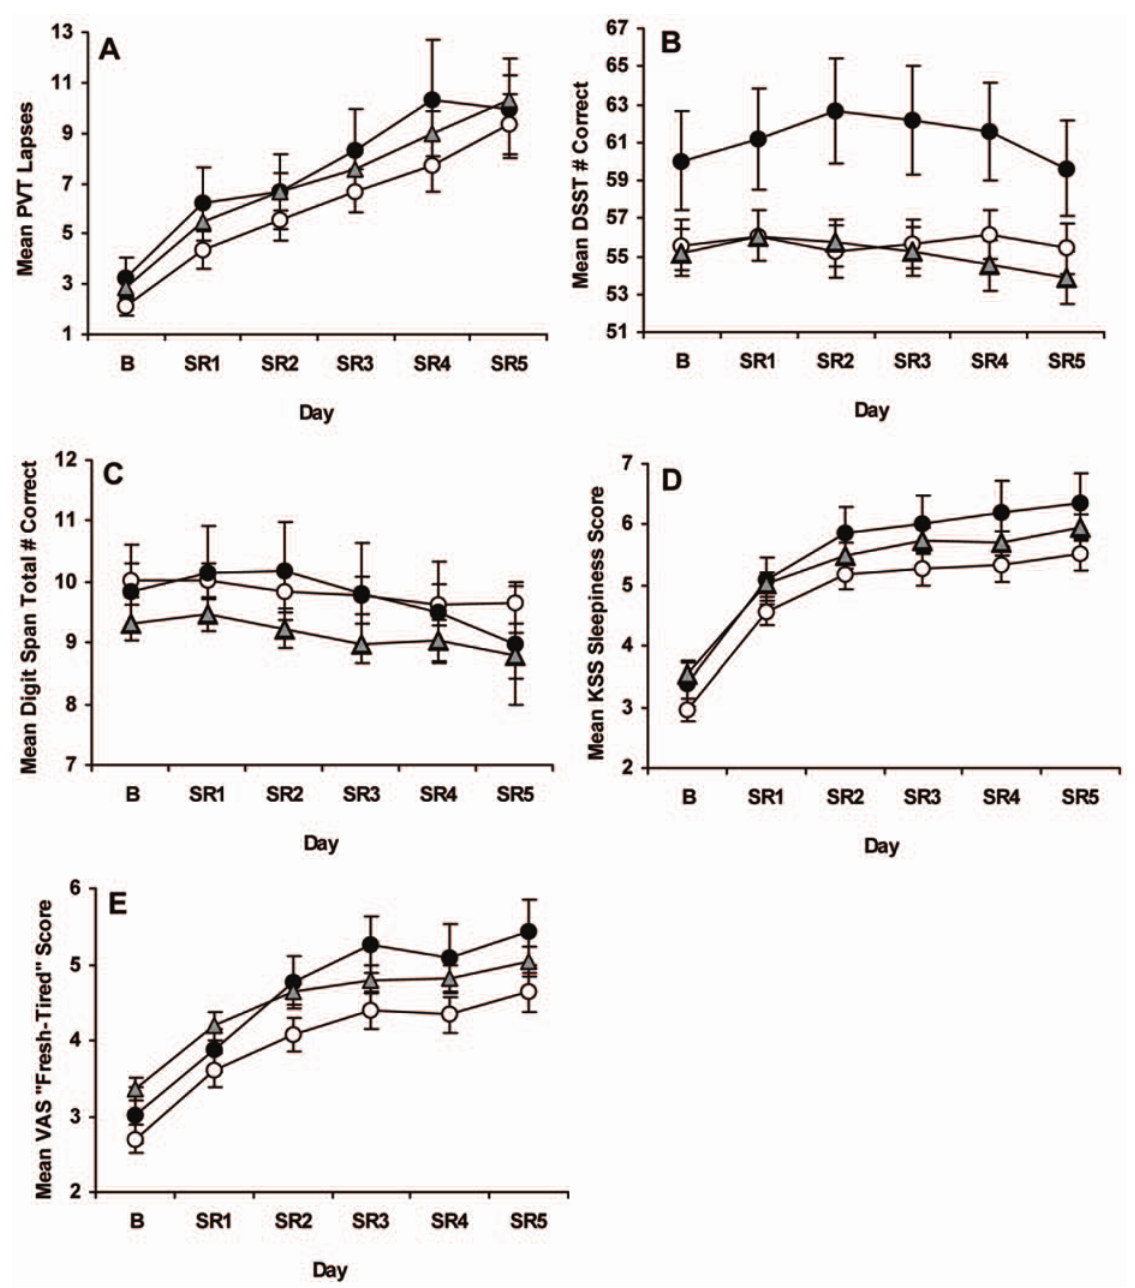
Figure 1. Neurobehavioral performance at baseline and during chronic partial sleep deprivation for the PER3 groups. Mean ( 6 SEM) (A) PVT lapses ( . 500 ms reaction times) per trial, (B) total number correct per trial on the Digit Symbol Substitution Task (DSST) and (C) Digit Span (DS) task, and scores per trial on the (D) Karolinska Sleepiness (KSS) and (E) ‘‘Fresh-Tired’’ Visual Analog Scale (VAS) at baseline (B) and each partial sleep deprivation/restriction night (SR1-SR5) for PER3 4/4 (open circles) , PER3 4/5 (gray triangles) and PER3 5/5 (closed circles) subjects. Although all genotypes showed increased PVT lapses and variability across chronic PSD, there were no differential responses in lapses nor did one genotype show more lapses than the other groups at baseline or during chronic PSD. PER3 5/5 subjects had better cognitive throughput than their PER3 4/4 counterparts, as indicated by significantly higher DSST scores across days; there were no differential changes in DSST scores across chronic PSD or significant changes across days. For all groups, DS total correct scores significantly decreased, and KSS and VAS scores significantly increased across chronic PSD, but there were no differential changes or group differences in these measures during chronic PSD.